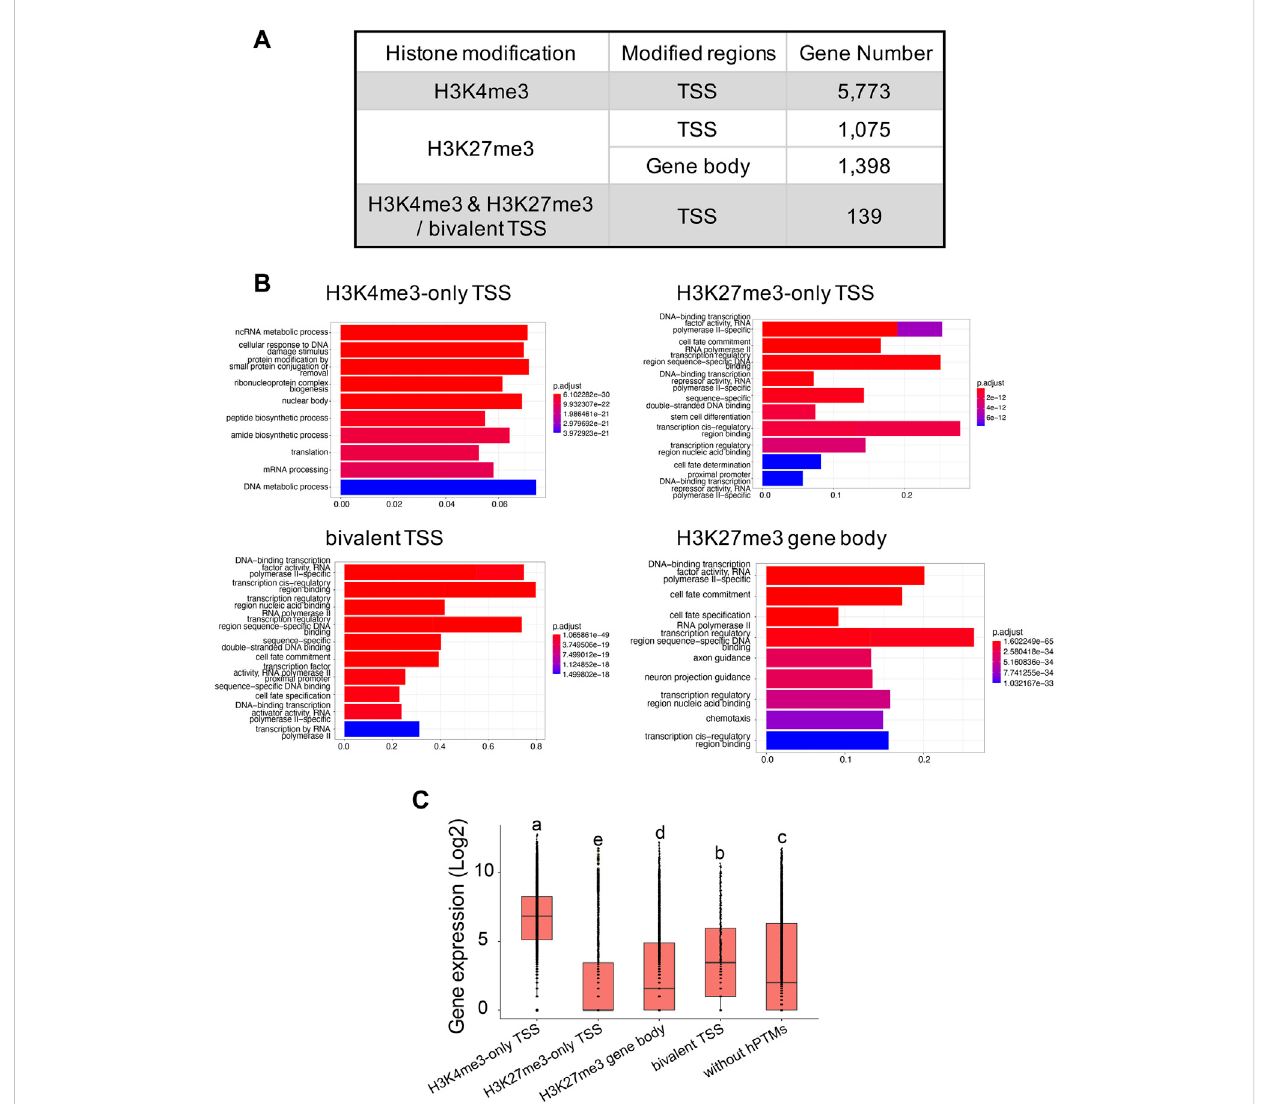
FIGURE 3 H3K4me3andH3K27me3peakanalysesinthe B. genome. (A) SummaryofthegeneswithH3K4me3-only,H3K27me3-onlyandbivalentdomainsat the TSSs, and genes with H3K27me3 at the gene body regions in B. dorsalis . (B) Top 10 over-represented GO terms in genes with H3K4me3-only, H3K27me3-onlyandbivalentdomainsattheTSSs,andgeneswithH3K27me3atthegenebodyregionsin B.dorsalis .Corrected p -valuesareindicatedby color, the warmer the color, the smaller the p -values. The vertical axis represents the GO term names and the horizontal axis represents gene ratio. (C) Boxplots showing the mean level of gene expression for genes with TSSs enriched by H3K4me3, H3K27me3, or both peaks and genes with gene bodiesenriched byH3K27me3and genesthatarenotmodi fi edbyhPTMs.The geneexpression levelswerecalculated basedonthelog2 ofRPKMvalues. The differences in gene expression levels among different modi fi cations were evaluated using one-way analysis of variance